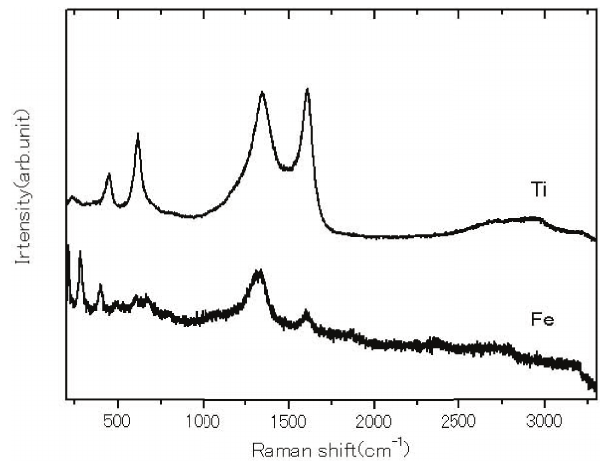
Figure 3. Raman spectra of Ti and Fe catalyst surface. The experimental condition of the treatment is the same as those in Figure 2. The pyrolysis temperature is 973